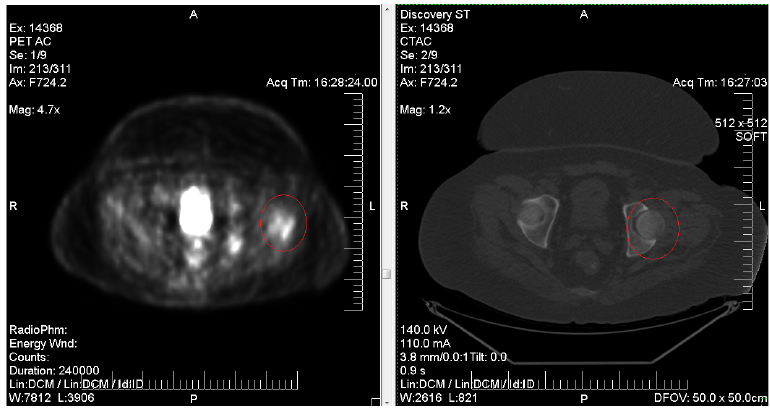
Figure 1. Abnormal hypermetabolism of the left trochanteric region. These PET/CT images were interpreted by evaluation of both the anatomic (CT) and metabolic (PET) data which were electronically fused.